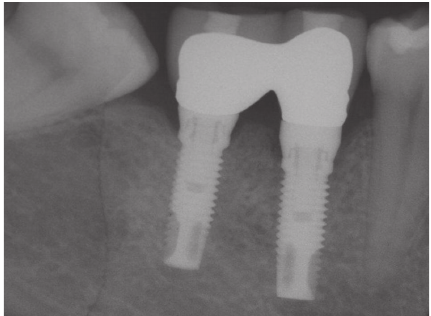
Figure 2: Periapical radiograph of the implants 8 years after